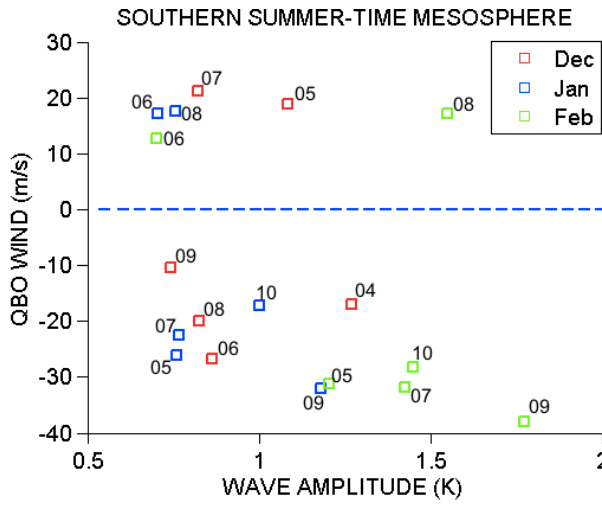
Fig. 10. Mean summer-time temperature amplitudes of the 16-day wave in the MLT at heights from ∼ 80–96km and latitudes of 50– 75 ◦ N as a function of QBO zonal winds at 10hPa.